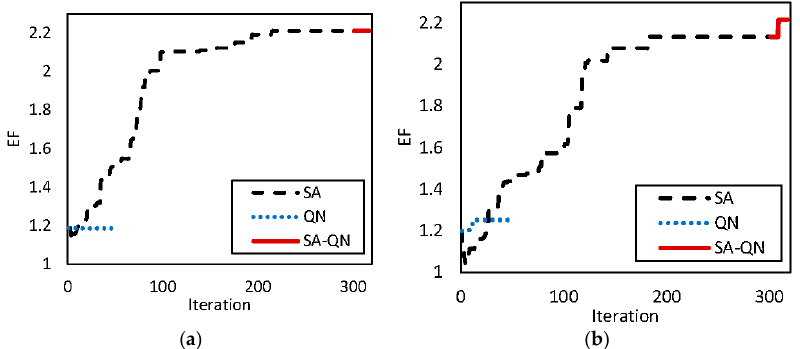
Figure 3. Evolution of EF during iterations of SA, QN and hybrid SA–QN for the initial